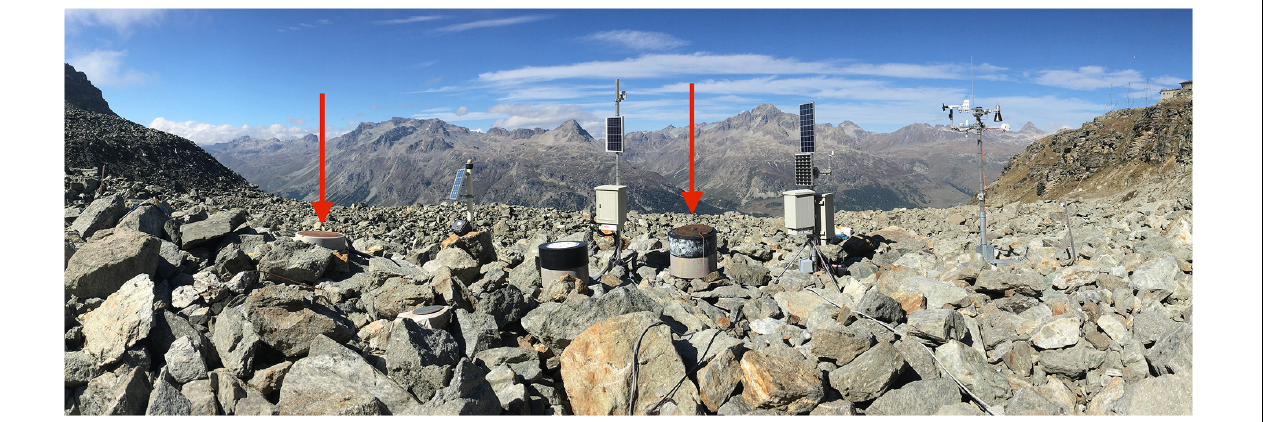
FIGURE 1 | Borehole site on rock glacier Murtèl-Corvatsch, Switzerland. The 1987-borehole is marked with the right arrow. The 2015 replacement borehole is on the far left (left arrow) and the meteorological station on the far right. A permanent GNSS device with a solar panel is mounted on a large boulder to the right of the 2015-borehole. Two other boreholes drilled in 2000 are not visible on the picture. Photo: J. Noetzli, October